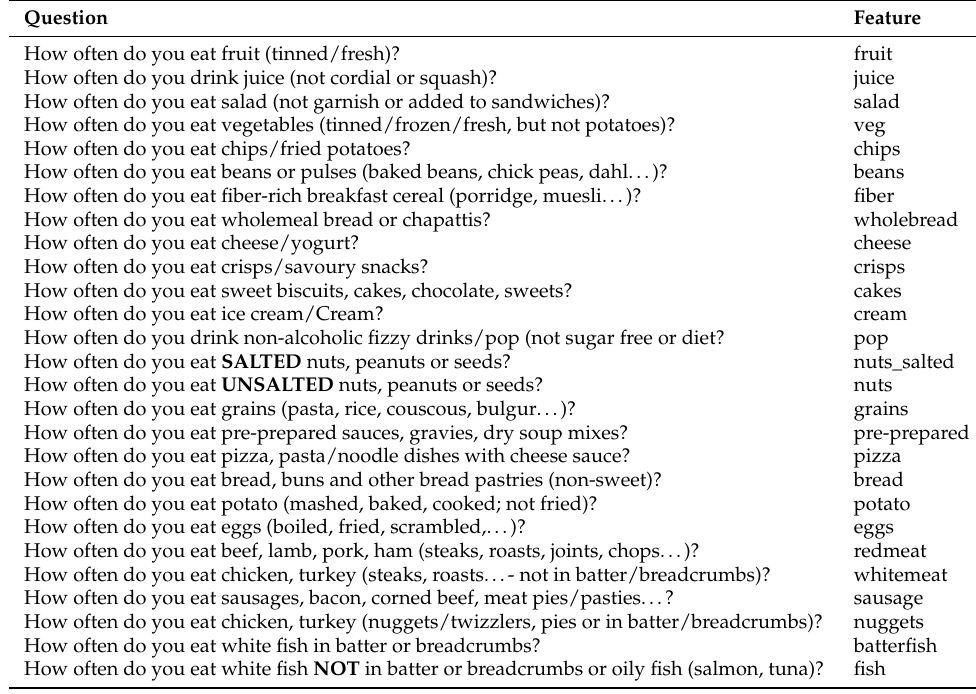
Table A1. List of questions and features in the